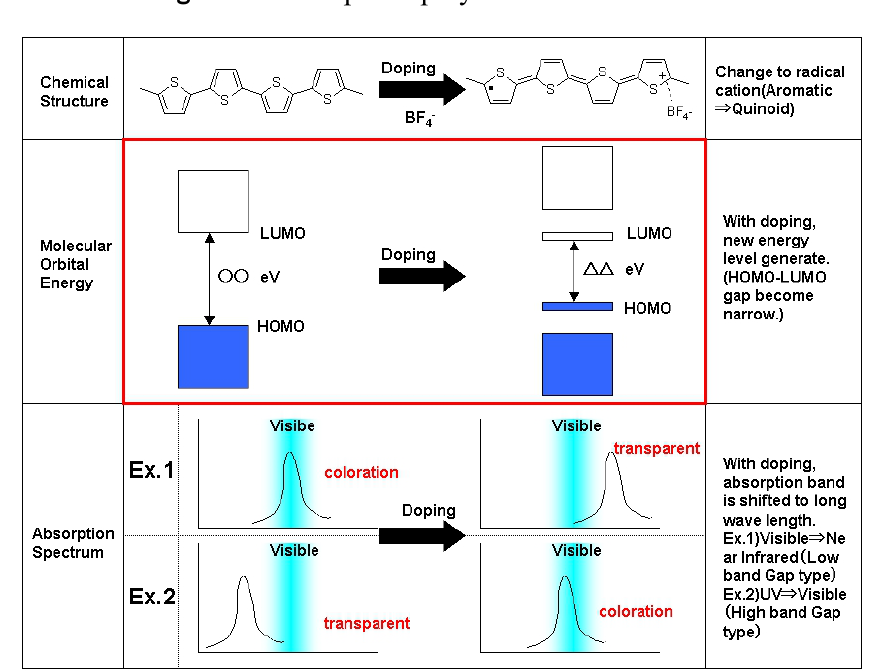
Figure 1. Principle of polymer